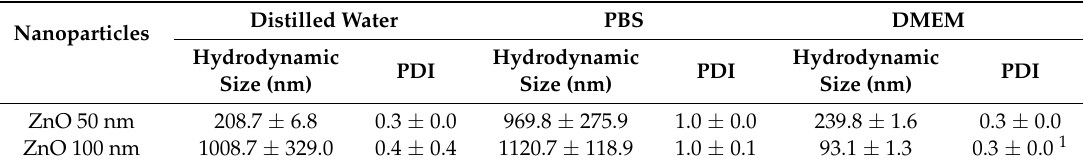
Table 1. Hydrodynamic size and polydispersity index (PDI) of ZnO of 50 and 100 nm determined in culture